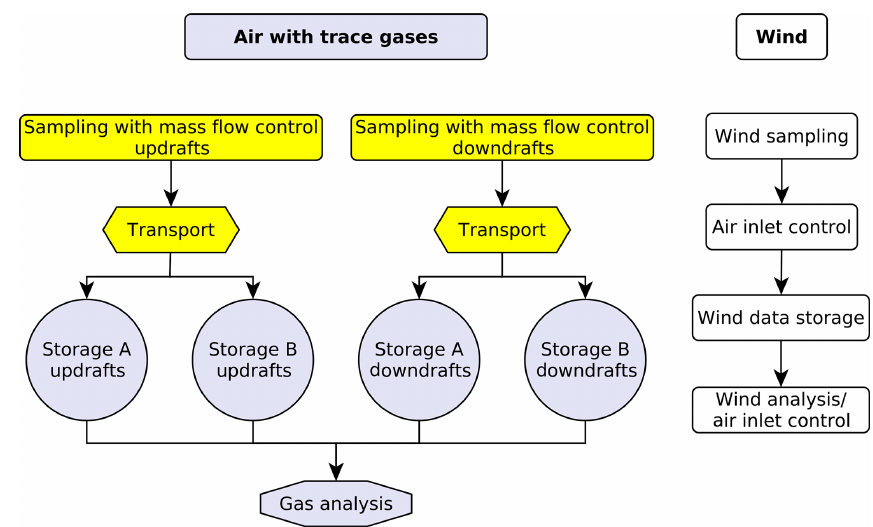
Figure 4. Schematic functional flowchart of true eddy accumulation system. Sampling of air with atmospheric constituents (scalars) shown on the left, sampling of wind vector shown on the right. Updrafts and downdrafts were sampled and stored via separate lines. One single analyzer was used with the sample supply alternating between the updraft and downdraft reservoirs every 150s (see Fig. 6). During a particular 30min period, bag set A was being filled with updraft and downdraft samples in the updraft and downdraft bags, respectively. At the same time bag set B was being analyzed and discharged, with the analysis alternating between updrafts and downdrafts. Every 30min, the operation of bag sets A and B, either filling or discharging, was swapped. The vertical wind velocity data (right) control the air sampling via instantaneous wind measurements and wind statistics.